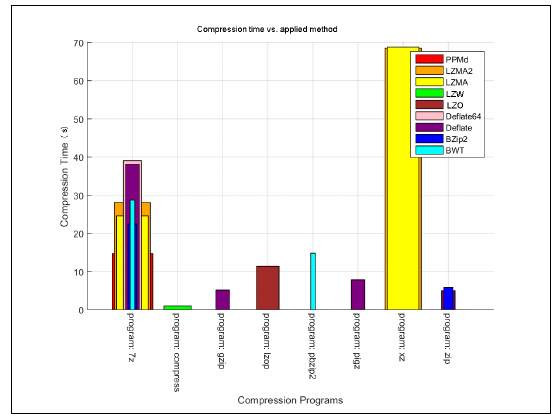
Figure 5: Average compression ratio among programs.